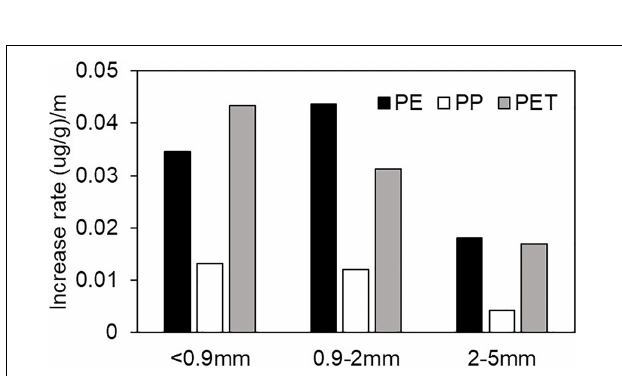
FIGURE 2 | Adsorbed Cu(II) on aged PE, PP, and PET microplastics.